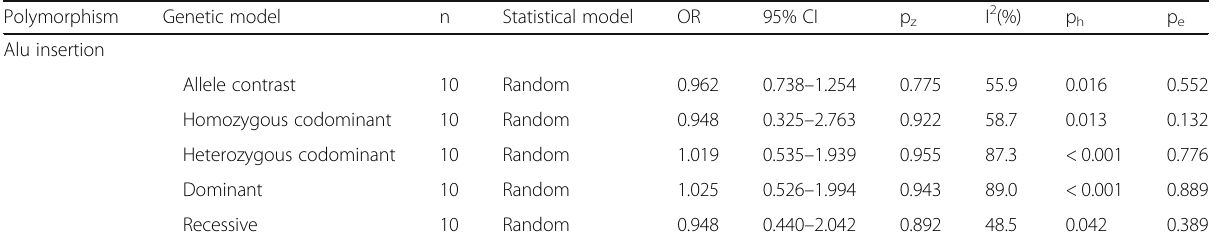
Table 3 Summarized ORs with 95% CIs for the association between PGR polymorphism and breast cancer